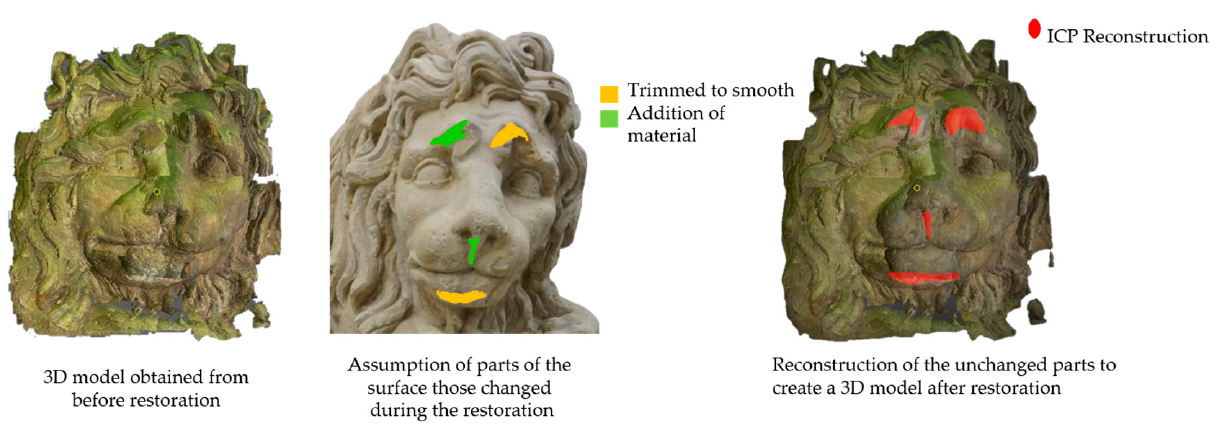
Figure 2. Three-dimensional model of the face of the ‘lying lion’; sandstone; 150 × 71 × 86 cm; owner: Radziwiłł Palace in Nieborów; possible solution to avoid alignment error for the face (~30 × 35 cm) in case of known reference of no change.